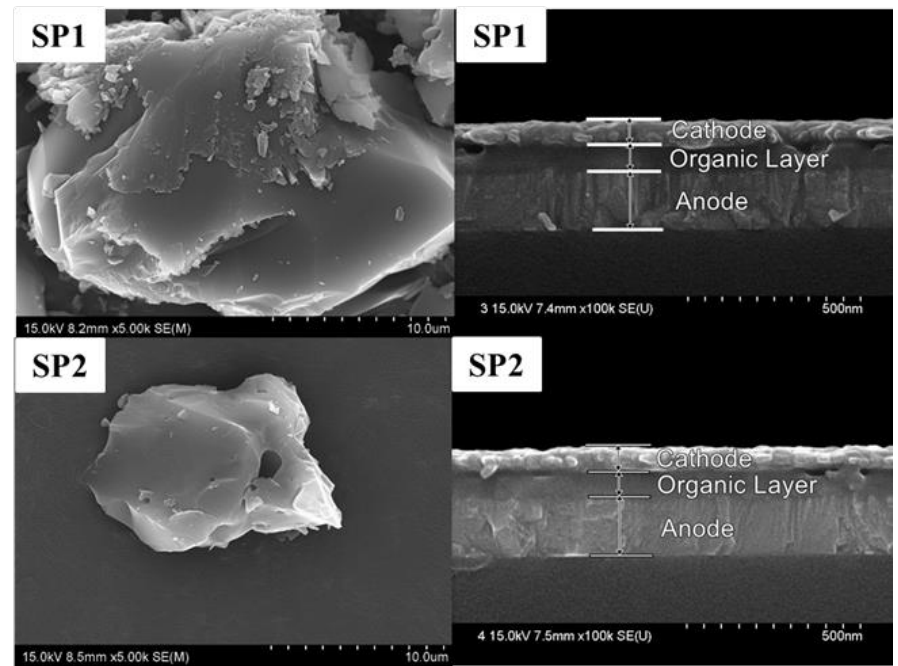
Figure 4. The scanning electron microscope (SEM) images of diphenylacridine (SP1) and phenothiazine (SP2) crystals and the cross-sectional views of the OLED devices.